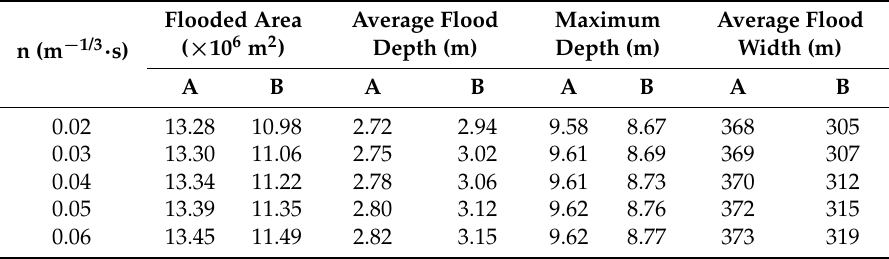
Table 3. Inundation depth and flood extent in Scenarios A and B with different roughness